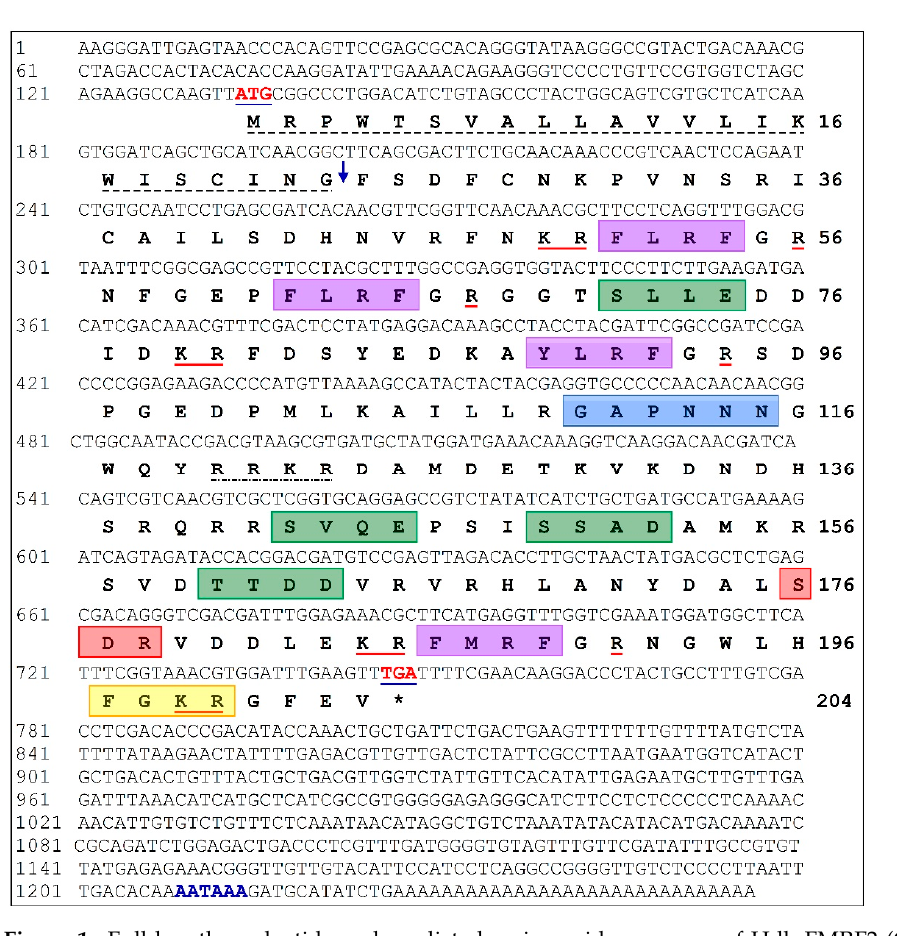
Figure 1. Full length nucleotide and predicted amino acid sequences of Hdh-FMRF2 (GenBank Accession No. MZ224009). The numbers at the right and the left sides indicate the amino acid and nucleotide locations in the sequence, respectively. Start and stop codons (*) are indicated in bold red and blue underlined text. The putative polyadenylation signal (AATAAA) is indicated in bold blue text. The signal peptide is underlined with a stich line in black. The down arrow indicates the predicted signal peptide cleavage site. The predicted FMRFamide related peptide (FaRP) family tetrapeptide motifs are indicated with violet box following the GR processing site. The monobasic and dibasic cleavage sites are underlined in red. A highly conserved tetrabasic furin-processing site (RRKR) is indicated with one dot break line. The green box indicates potential casein kinase II phosphorylation sites. The blue box indicates a N-myristoylation site. The protein kinase C phosphorylation site is indicated with red box. An amidation site is indicated with a yellow box.